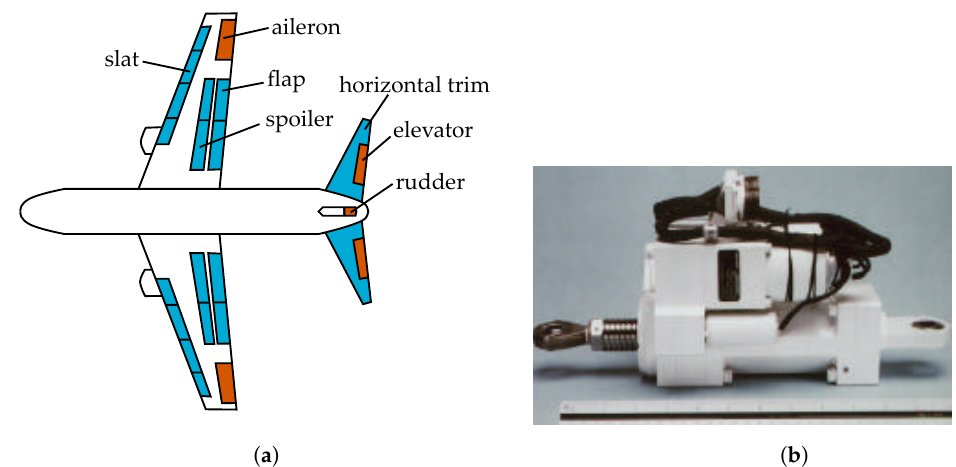
Figure 1. Flight control surfaces and example EMA ( a ) Primary (red) and secondary (blue) flight control surfaces ( b ) Photograph of a primary flight control (aileron) EMA [14]. ©IEEE. Reprinted,